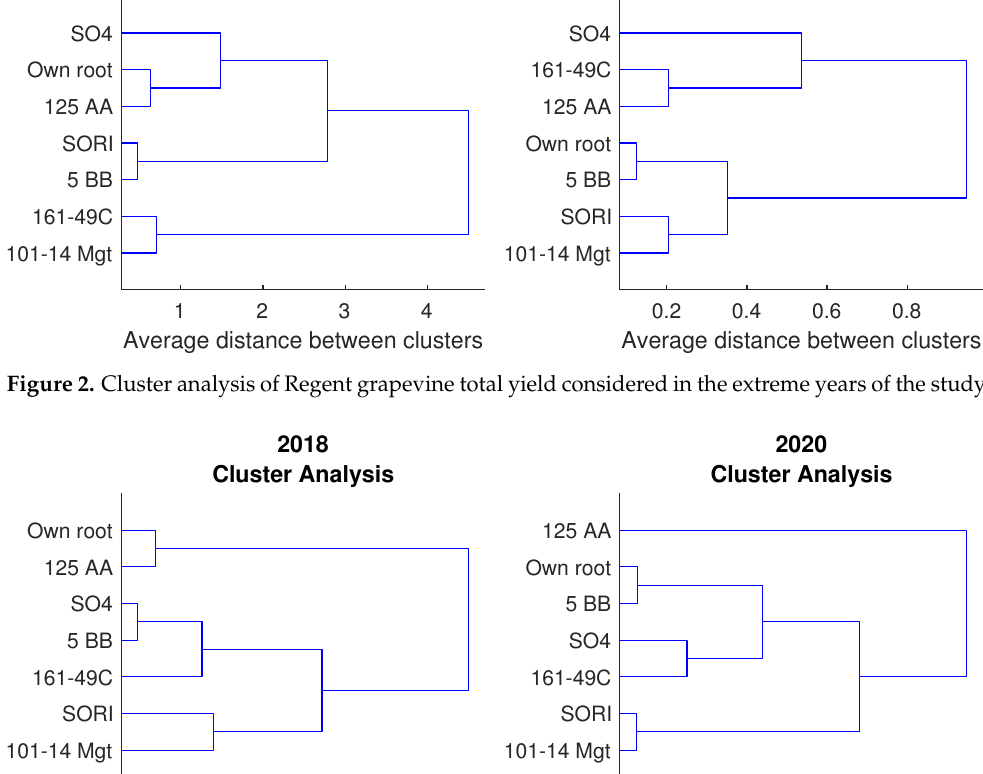
0.02 0.04 0.06 0.08 0.1 0.12 Figure 3. Cluster analysis of Regent grape berry weight considered in the extreme years of the study. Three distinct clusters were observed in berry weights in both years analyzed. The third cluster in both years consists of SORI and 101-14 Mgt rootstocks. In 2018, cluster one consisted of own root and rootstock 125 AA, while cluster two consisted of SO4 and 5 BB, showing the least similarity to 161-49C. In 2020, the first cluster consisted of the 125 AA rootstock, which was also the outlier, and the other types analyzed. The second-largest cluster consisted of two subgroups, the first being own root and rootstock 5 BB, while the second subgroup consisted of SO4 and